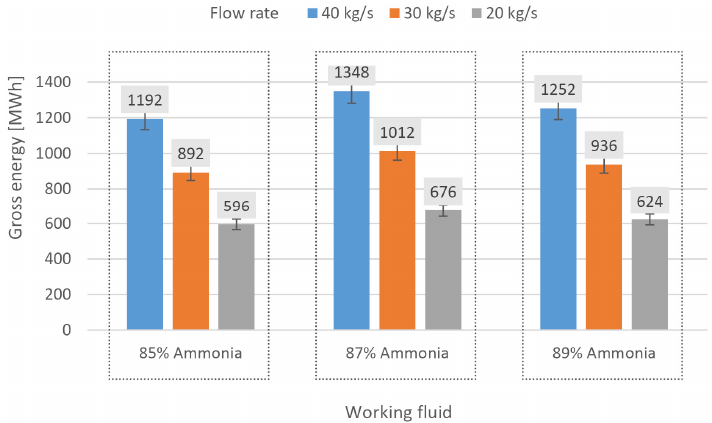
Figure 9. Comparison of the quantity of electricity it is possible to generate in the AII variant using the ORC Cycle.